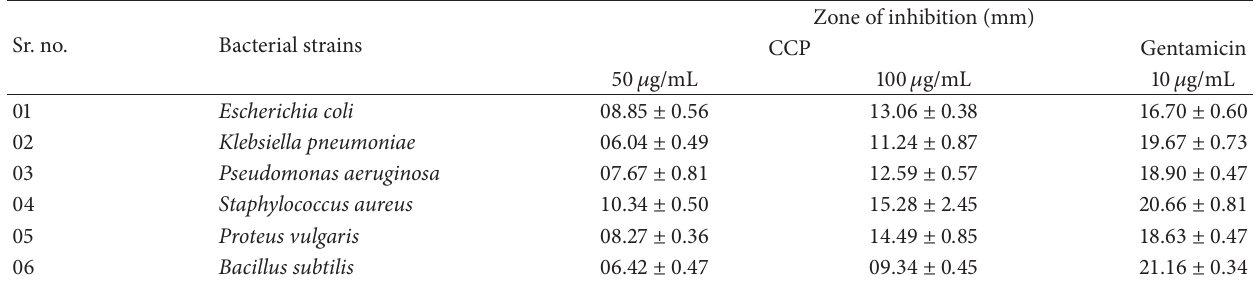
Table 6: Antibacterial activity of crude protease.